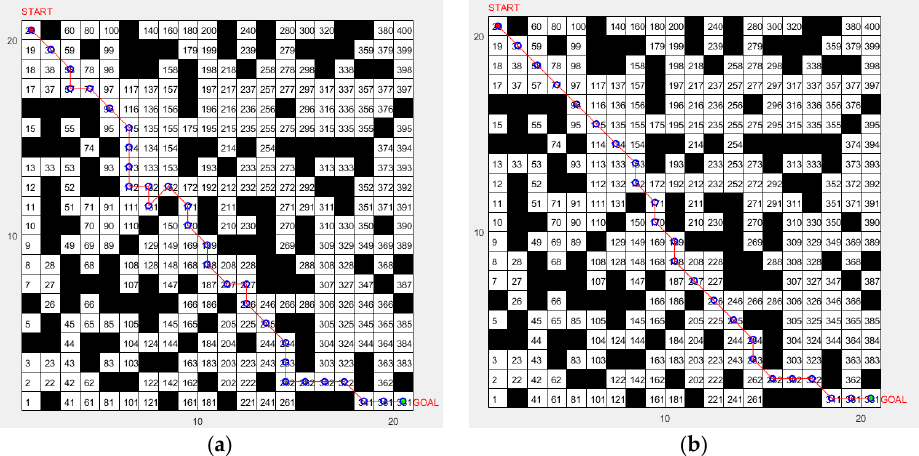
Figure 3. ( a ) Artificial fish swarm algorithm; ( b ) the presented hybrid artificial fish swarm algorithm.